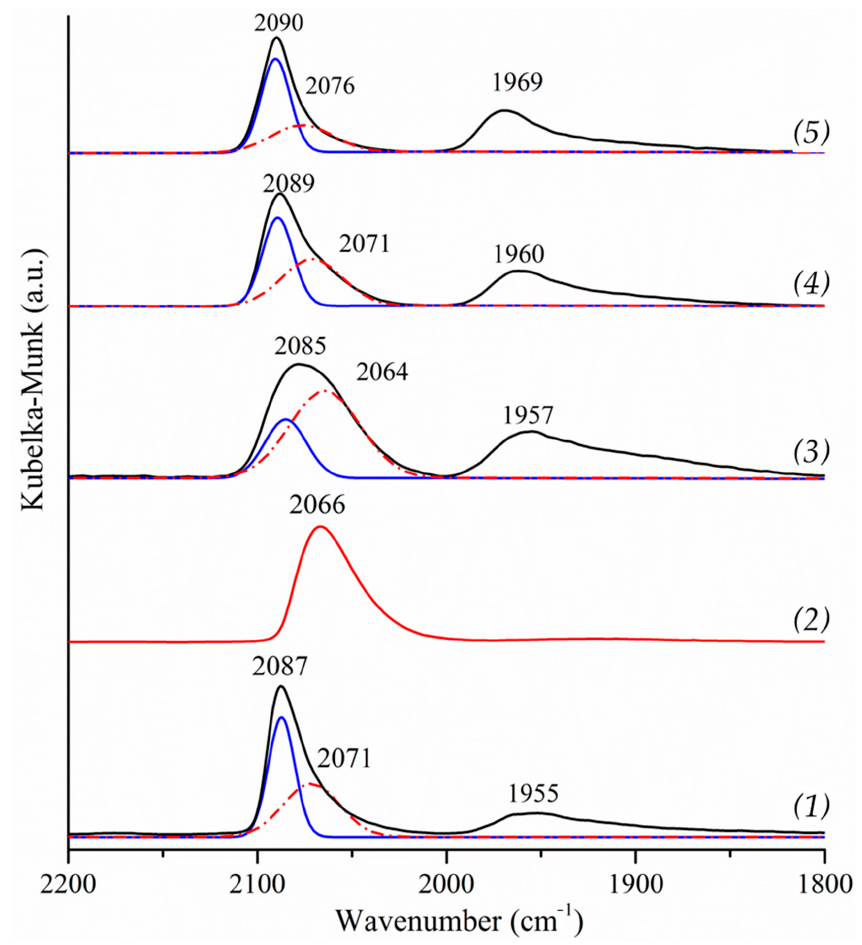
Figure 3. DRIFT spectra of adsorbed CO for PdIn/Al 2 O 3 after treatments in situ: (1) initial sample; (2) reduction at 500 °C for 1 h; (3) oxidation at 25 °C for 30 min; (4) oxidation at 100 °C for 30 min; (5) oxidation at 250 °C for 30 min. Blue solid ◦ C for 1 h; (3) oxidation at 25 ◦ C for 30 min; (4) oxidation at 100 ◦ C for 30 min; line corresponds to metallic Pd, red dotted line to bimetallic phase. (2) reduction at 500 (5) oxidation at 250 ◦ C for 30 min. Blue solid line corresponds to metallic Pd, red dotted line to bimetallic